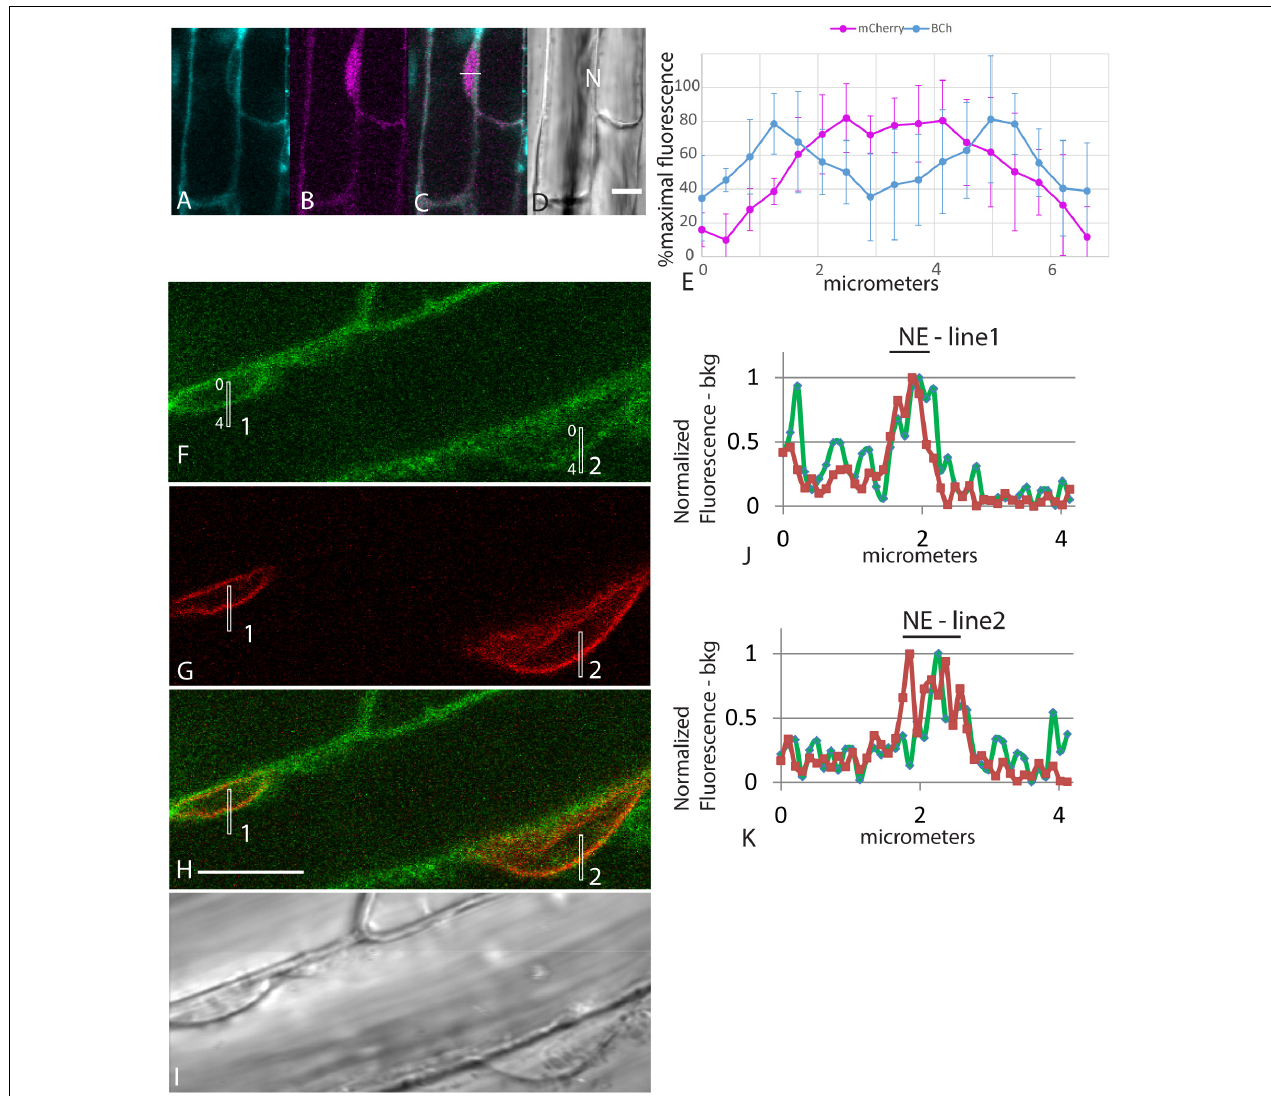
FIGURE 3 | NE label with BCh. (A–E) Comparison of BCh staining after 25 min with expression of cytosolic mCherry. (A) BCh signal. (B) cytoplasmic mCherry signal. (C) Merged image of (A and B) , showing the line across which the profile was analyzed. (D) Bright-field image. N, nucleus. Scale bar = 10 µ m. (E) Average line plot values (plus/minus standard deviation) of four nuclei lying flat against the plasma membrane, as in (A–D) . Note that mCherry has a broad peak and that BCh has two peaks at the edges of the nuclei. (F–K) BCh label after 30 min and colocalization of the label with the NE marker SUN-RFP. (F) BCh labels the PM and the NE of cells in the elongation zone of roots. (G) SUN-RFP expression in the NE of the cells shown in (F) . (H) Merged fluorescence micrographs (F,H) . Scale bar = 10 µ m. (I) DIC image of the fluorescent region in (F–H) . (J) Fluorescence in the 4 µ m line outlined in region 1 of (F–H) that crosses the NE. (K) Fluorescence in the 4 µ m line in region 2 of (F–H) . In (F and G) , the fluorescence intensity in the BCh channel is green, while that in the SUN-RFP channel is